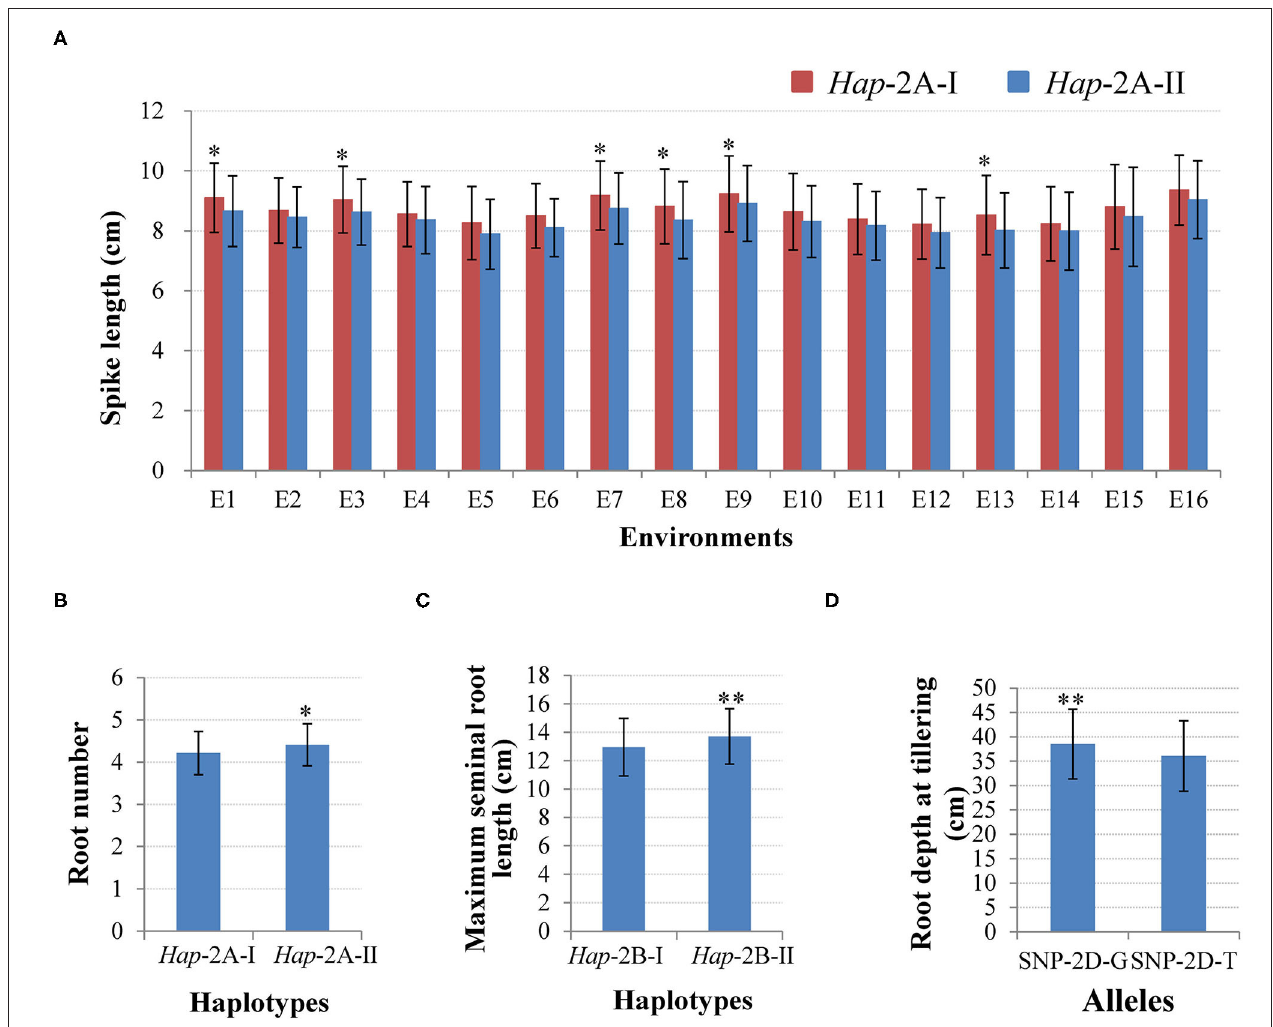
FIGURE 5 | Phenotypic comparisons between different haplotypes/alleles for TaWRKY51s . Comparisons of spike length (A) and root number (RN) (B) for the two haplotypes of TaWRKY51-2A , maximum seminal root length for TaWRKY51-2B (C) , and root depth for the two alleles of TaWRKY51-2D at the tillering stage (D) . *, ** indicate significance at 0.05 and